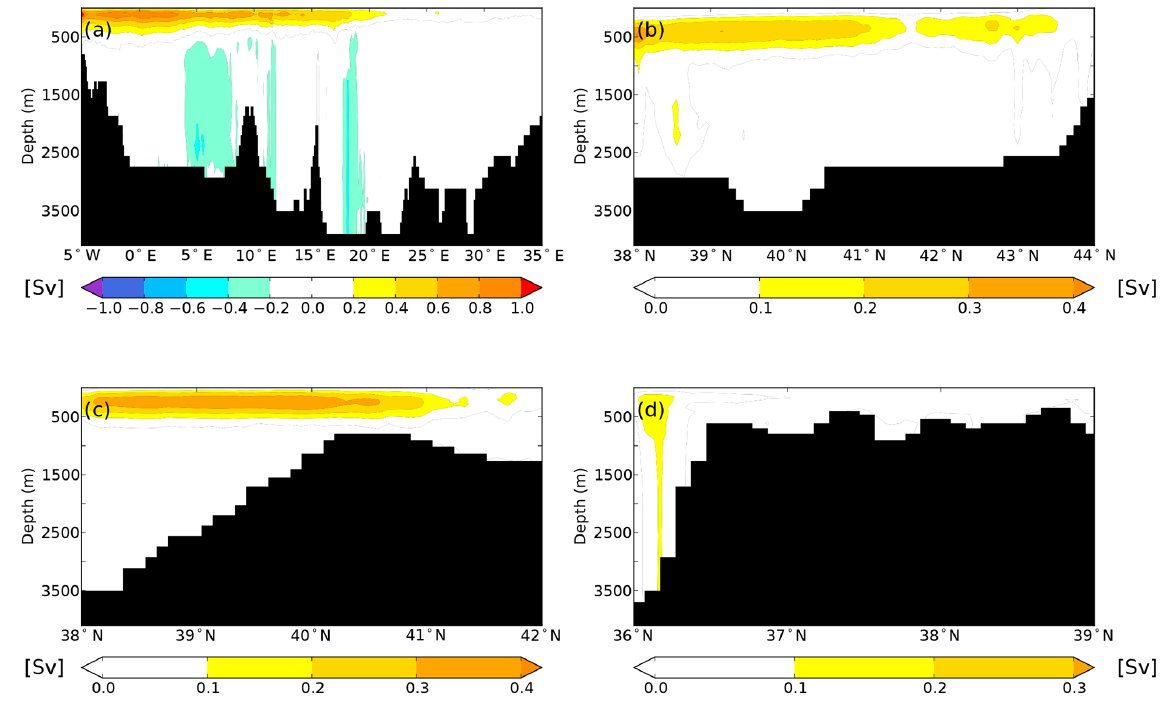
Figure 13. ZOF (a) and MOF ( b , Gulf of Lion, c , Adriatic/Ionian Sea, d , Aegean Sea) for the EHOL experiment, averaged over the last 30 years of simulation. These overturning stream functions were calculated in the same way as in Fig. 6, providing a strict comparison with the HIST and PICTRL